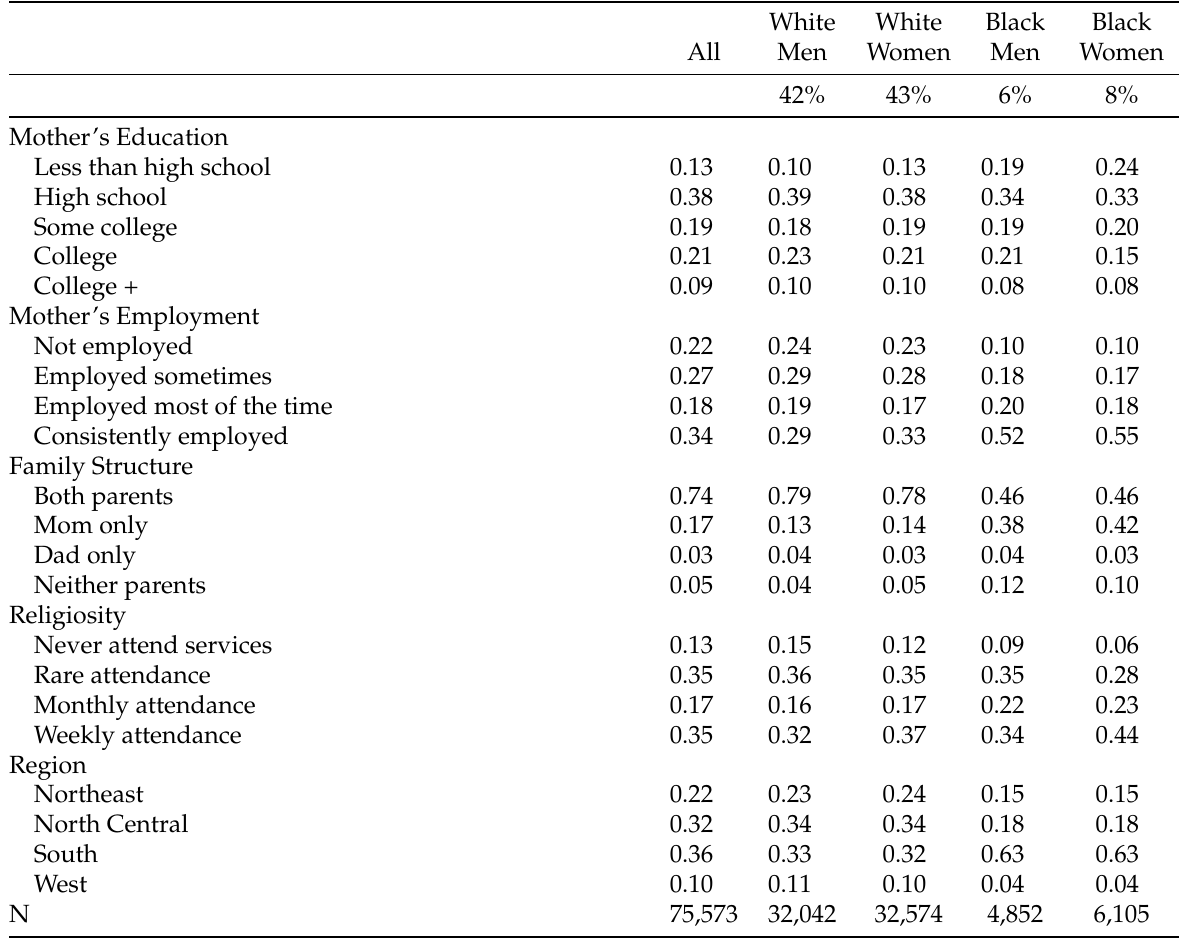
Table 1: Percentage distribution of independent variables, 1976 to 2014